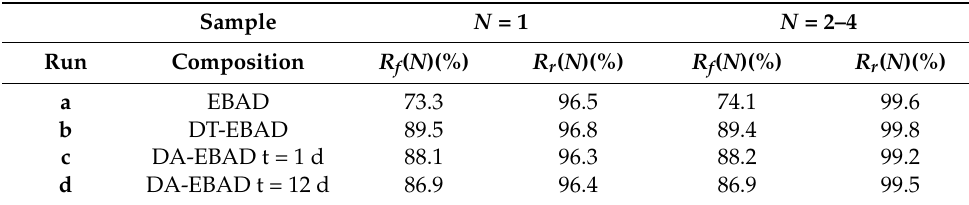
Table 2. Results of the thermocycle cantilever